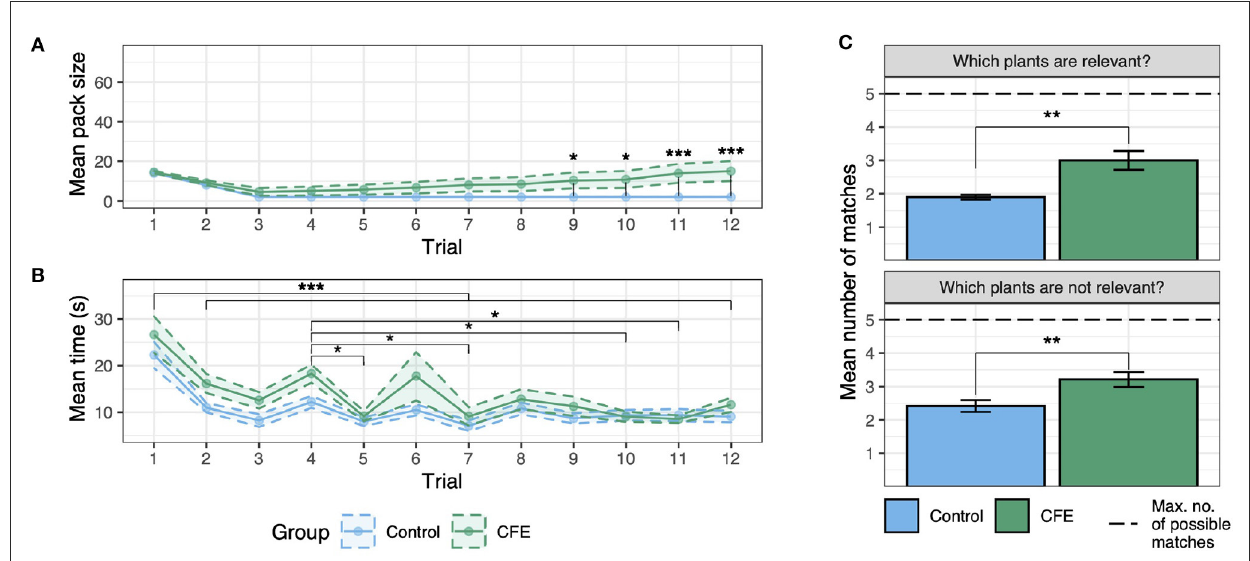
FIGURE5 Experiment 1: Development of (A) mean pack size per group by trial, (B) mean decision time per group by trial, and (C) mean number of matches between user judgments and ground truth for survey items assessing relevant plants and irrelevant plants, respectively. Shaded areas in (A, B) , and error bars in (C) denote the standard error of the mean. Asterisks denote statistical significance with ∗ p < 0.05, ∗∗ p < 0.01, and ∗∗∗ p < 0.001,